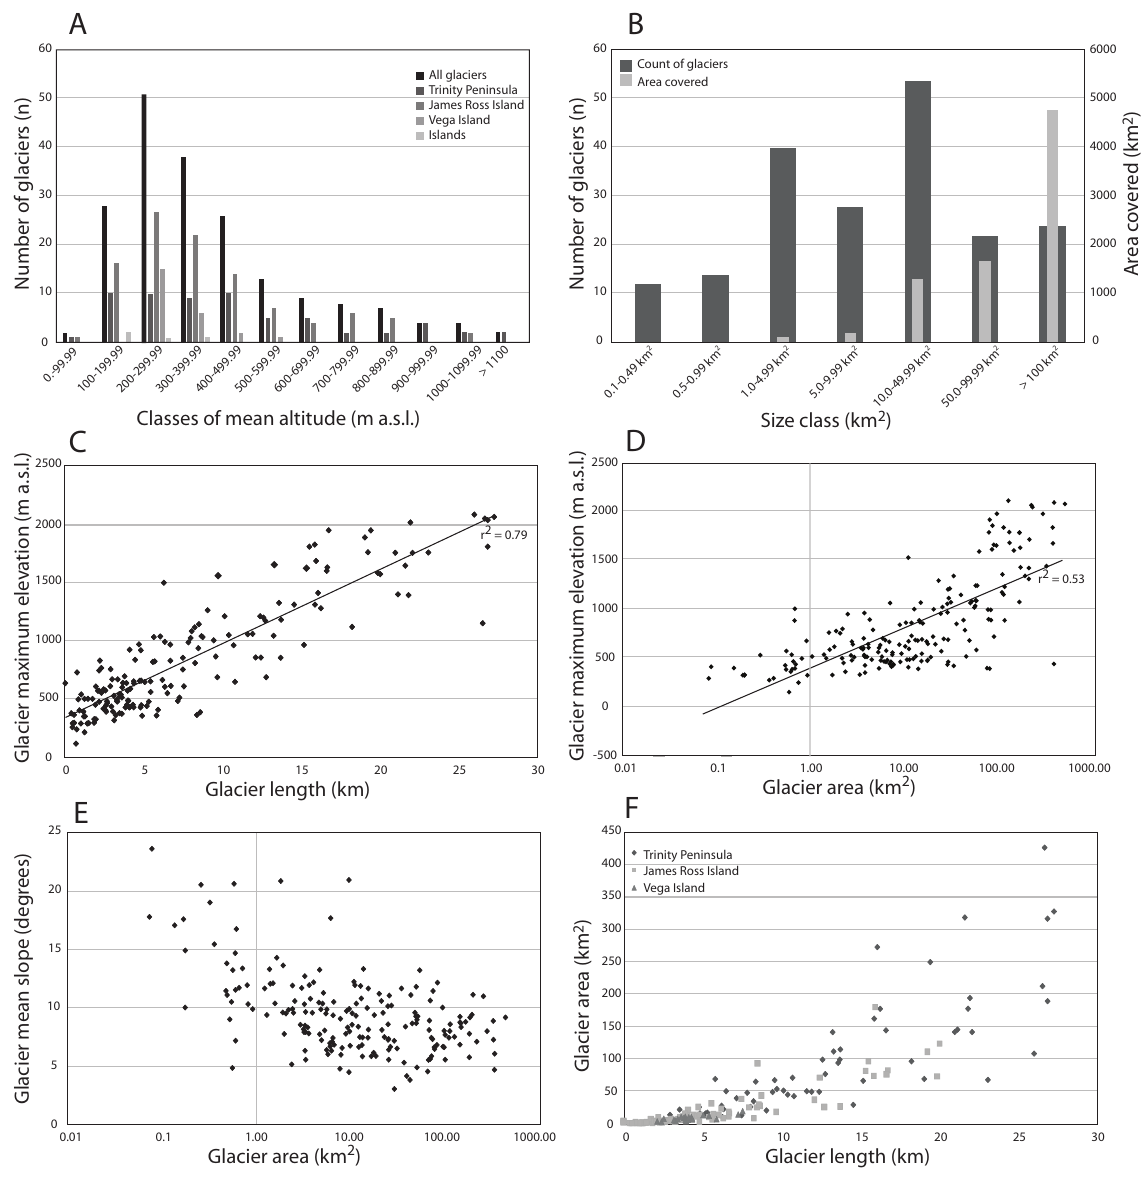
Fig. 2. Glacier inventory data. See Table 5 for p-values. (A) Mean elevation of glaciers in each region. (B) Frequency distribution of different glacier area classes, compared with total area in each size class. (C) Glacier maximum elevation and length. (D) Maximum elevation and area. (E) Mean slope and log glacier area. (F) Glacier area and